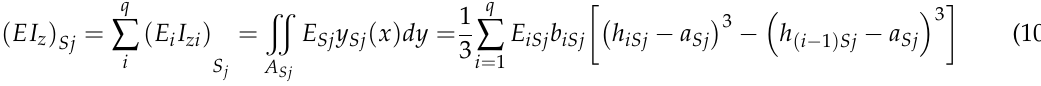
6 of 18 Figure 4. Schematic of the pVEH microdevice equivalent resonator, which is divided in three different cross-sections.